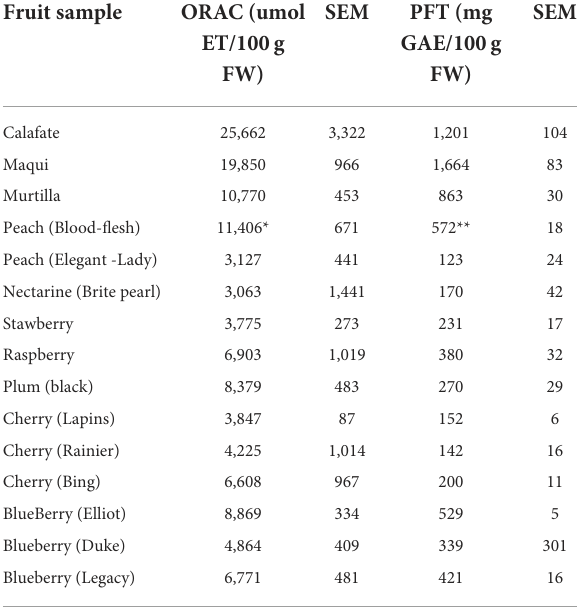
TABLE 1 Comparison of ORAC and total polyphenol between blood-flesh peach and other peaches varieties and fruits. Fruit